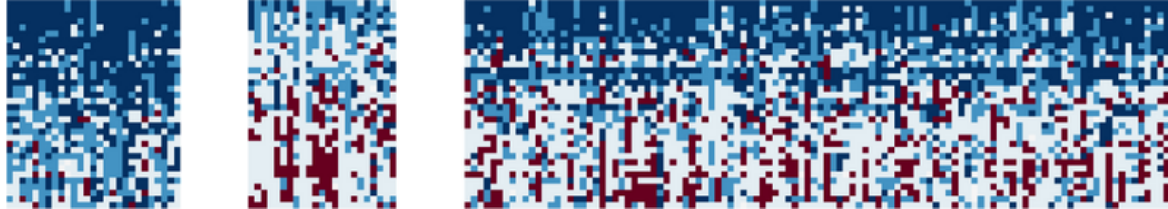
Figure 5. Questionnaire responses and the three clusters of data scientists. A block represents a cluster assignment (constructed exactly like that of Figure 3), where the first block is the cluster of data science unicorns. We find the third (and the largest) group more representative of the modern data scientist and completely ignore the lower-expertise group of self-declared data scientists in the second block. The ordering of the rows (i.e., the questionnaire items) is the same as it is in Figures 2 and 3, and the labels are omitted for ease of